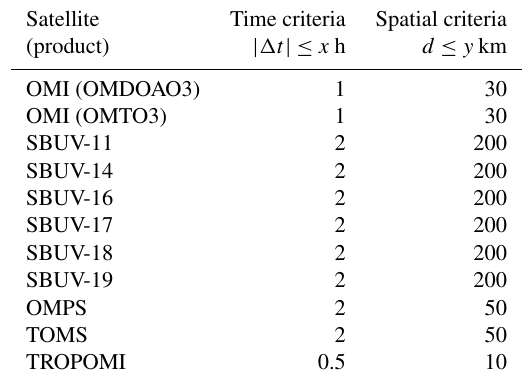
Table 3. Satellite comparison